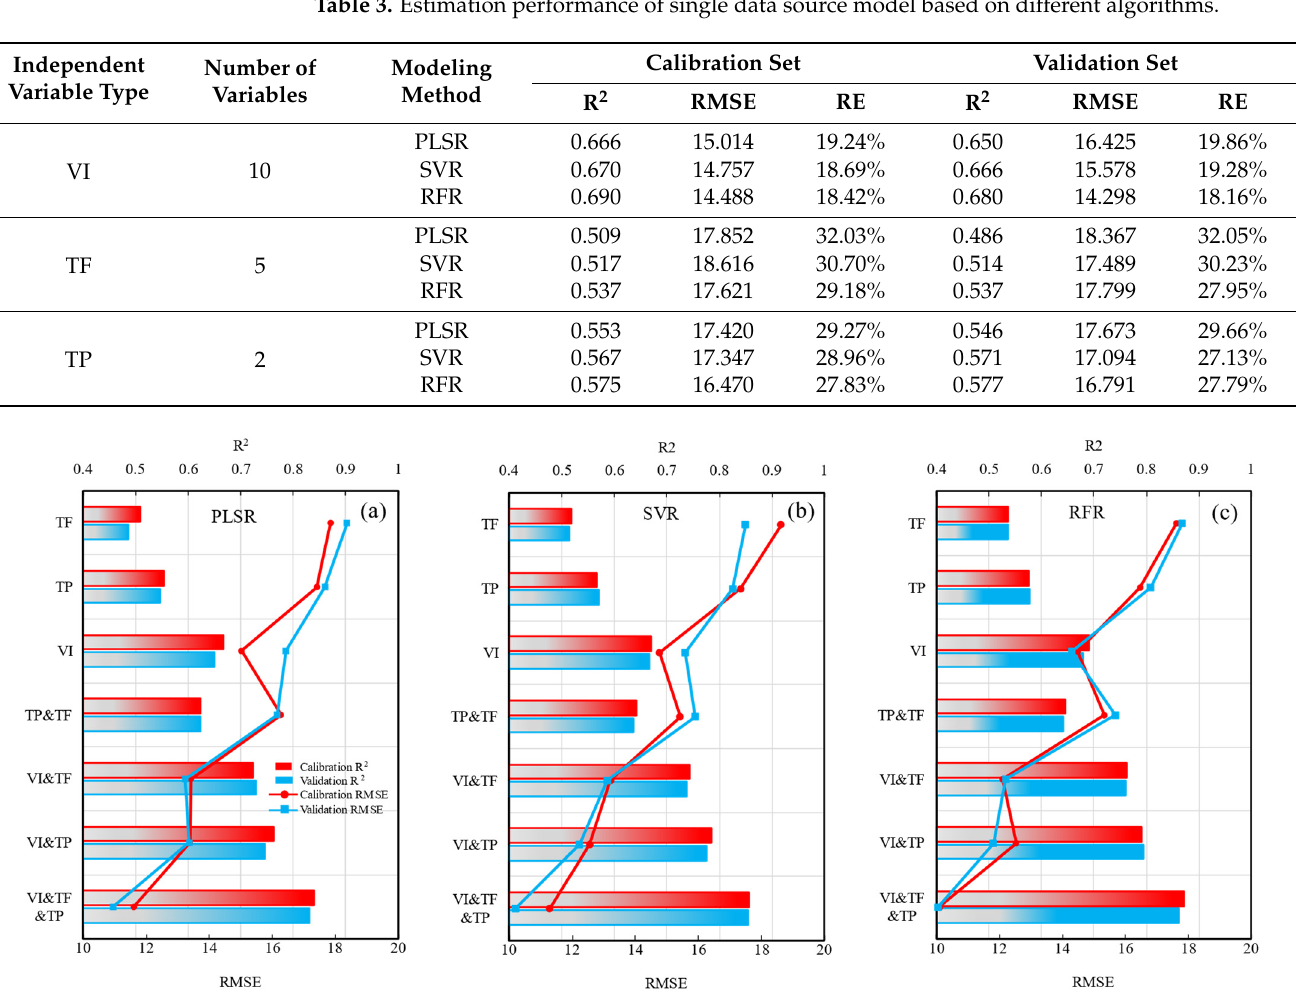
Figure 9. Prediction performance of different models with various input feature types.